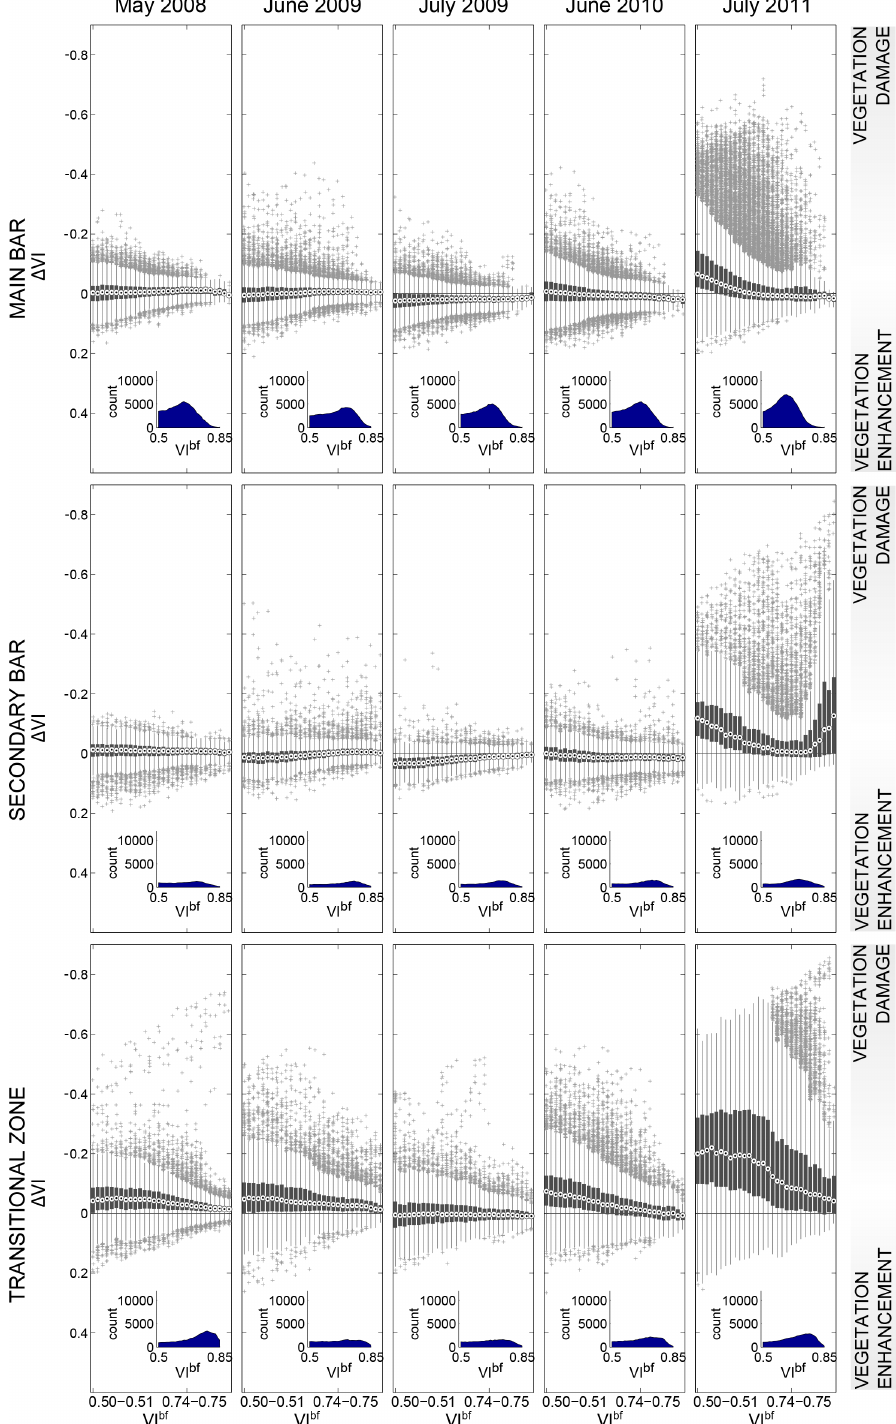
Figure 6. Boxplots for vegetation response (cid:49) VI conditioned on the VI before the flood VI bf (displayed VI values correspond to NDVI). (cid:49) VI < 0 indicates vegetation damage and (cid:49) VI > 0 vegetation enhancement. The boxplots are displayed for VI bf values of 0.5–0.85. Points are drawn as outliers if they are larger than q 3 + 1.5( q 3 − q 1 ) or smaller than q 1 − 1.5( q 3 − q 1 ), where q 1 and q 3 are the 25th and 75th percentiles, respectively. Subplots display the distribution of VI before flood VI bf for the corresponding flood and floodplain unit. Insets show the histograms of VI bf